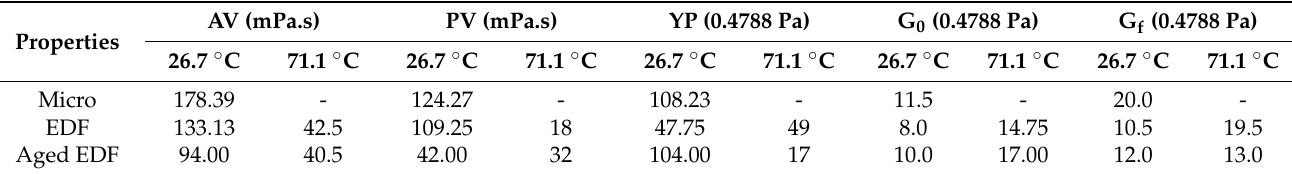
Table 4. Experimental properties for the EDF fluid and microemulsion, before and after aging. Properties